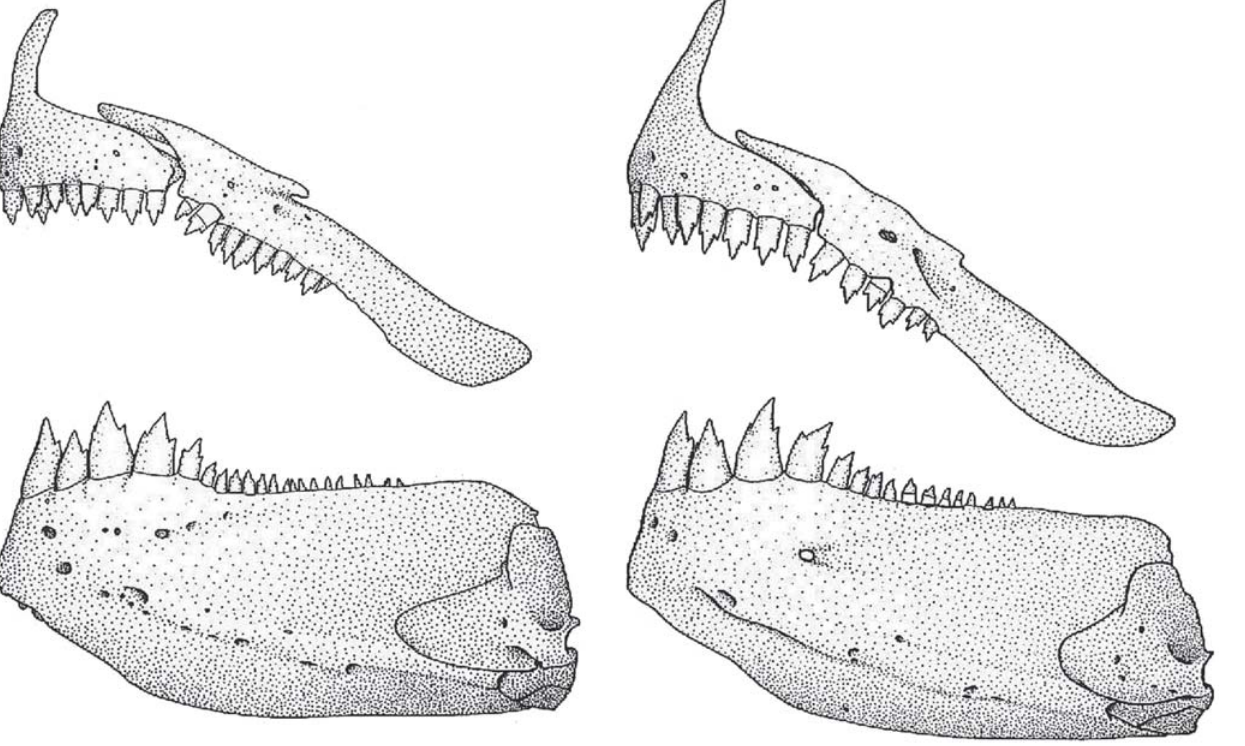
Fig. 87. Mimagoniates microlepis , adult male, USNM 249885, 41.2 mm SL; jaws and dentition, lateral view, right side, anterior at